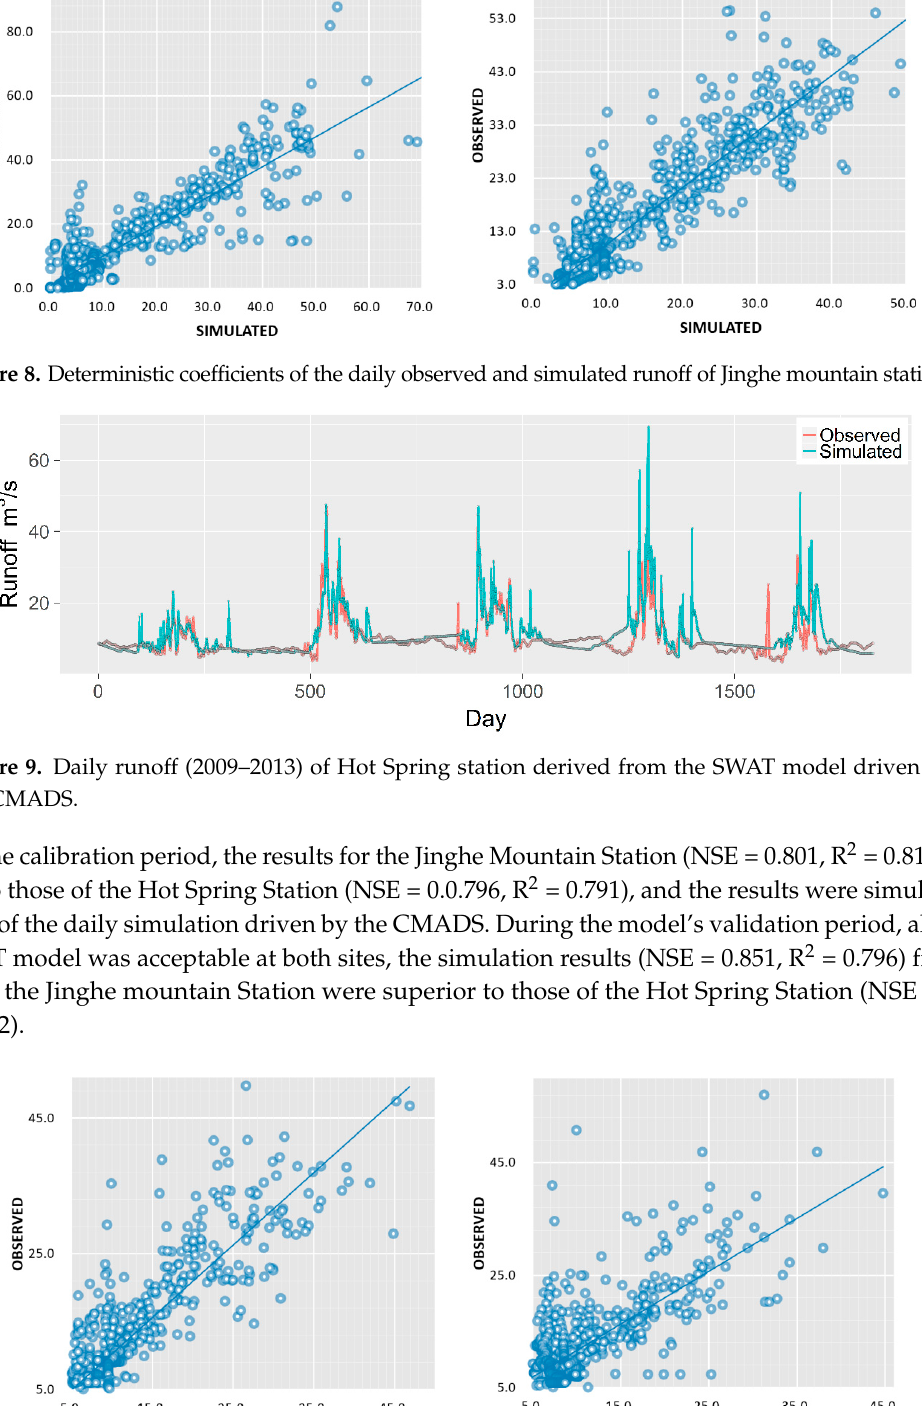
Figure 10. Deterministic coefficients of the daily observed and simulated runoff of Hot Spring station.